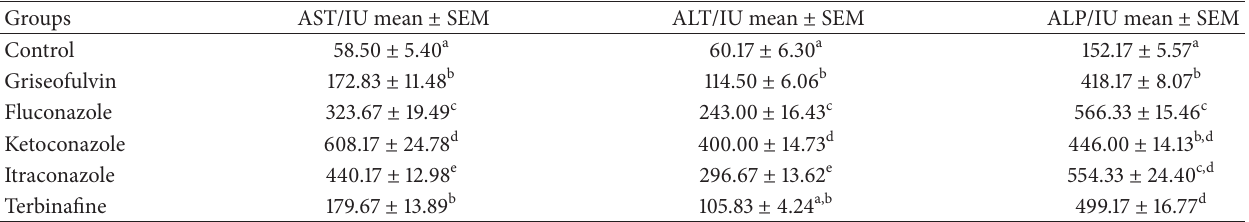
Table 2: Effect of the five oral antifungal agents (griseofulvin, fluconazole, ketoconazole, itraconazole, and terbinafine) on serum activities of AST, ALT, and ALP in rats after 28 days of